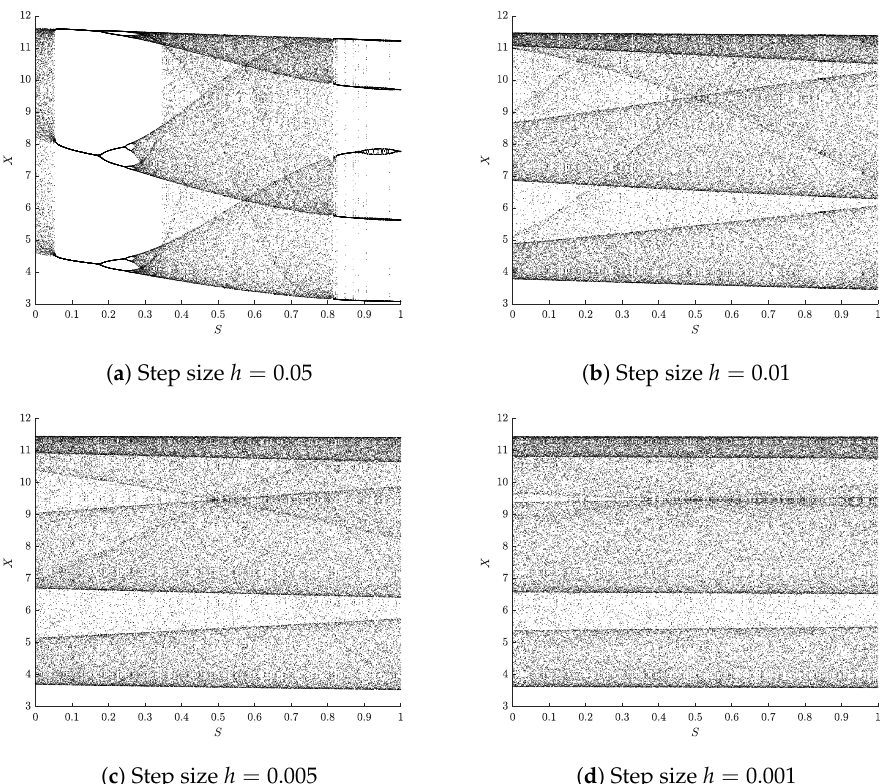
Figure 10. Bifurcation diagrams of the Rössler system for the symmetry coefficient variation at different numerical integration steps.